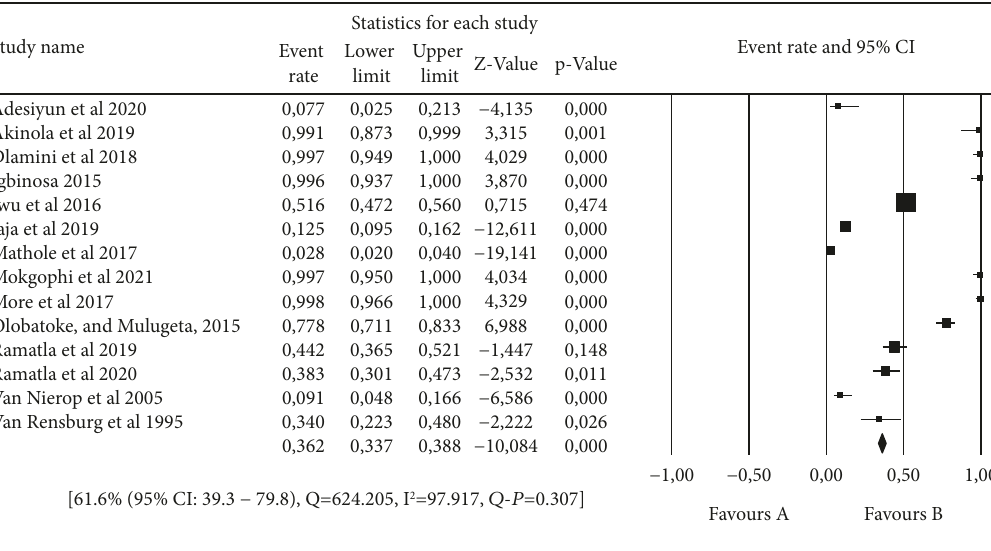
Figure 2: Forest plot showing the pooled estimates of Salmonella serovars from animals. The squares demonstrate the individual point estimate. The diamond at the base indicates the pooled estimates from the overall studies.